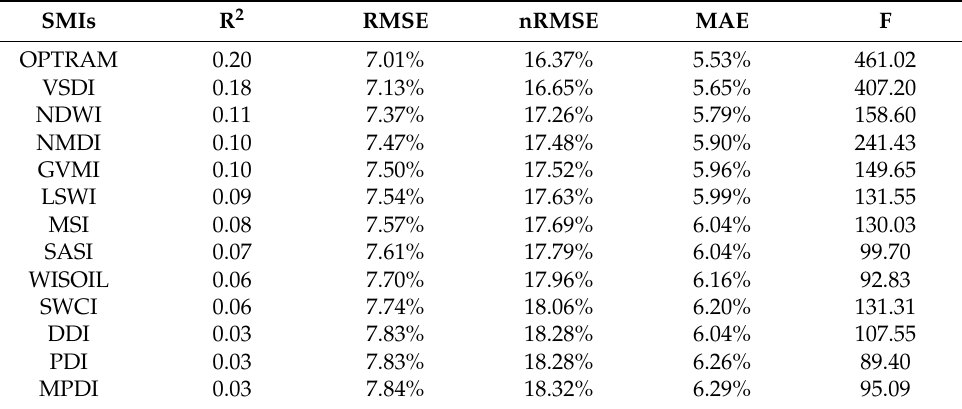
Table 3. Comparisons between aircraft SM and optical SMIs with MODIS data.